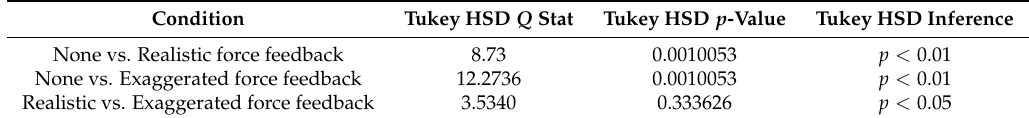
Table 3. Tukey’s HSD results.